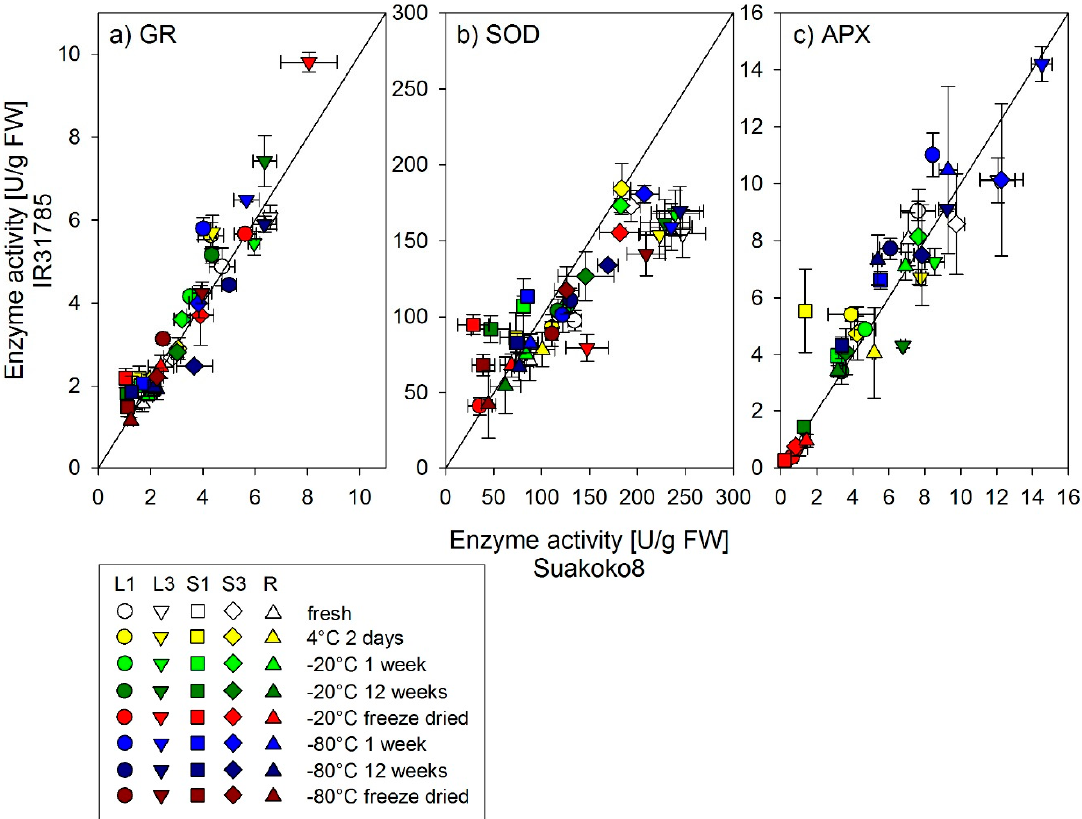
5 of 11 Figure 1. Enzyme activity of ( a ) glutathione reductase (GR), ( b ) superoxide dismutase (SOD), and ( c )